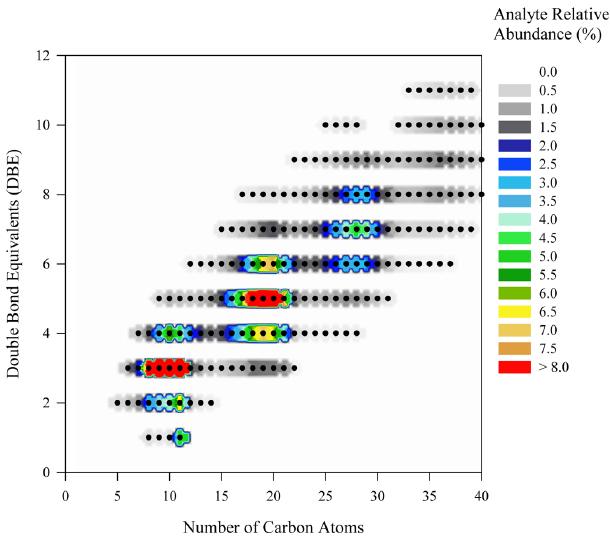
Fig. 4. Double bond equivalents (DBE) versus number of carbon atoms. The color represents the relative abundance of negative ions. Data points common between the samples with all relative abun- dances are included in the